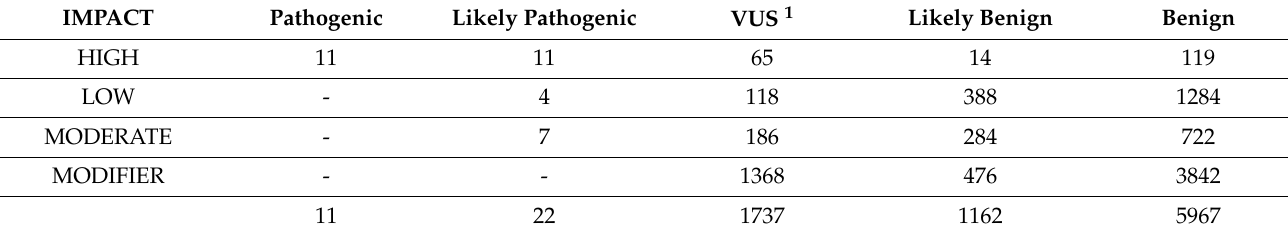
Table 2. Variant classification in one random